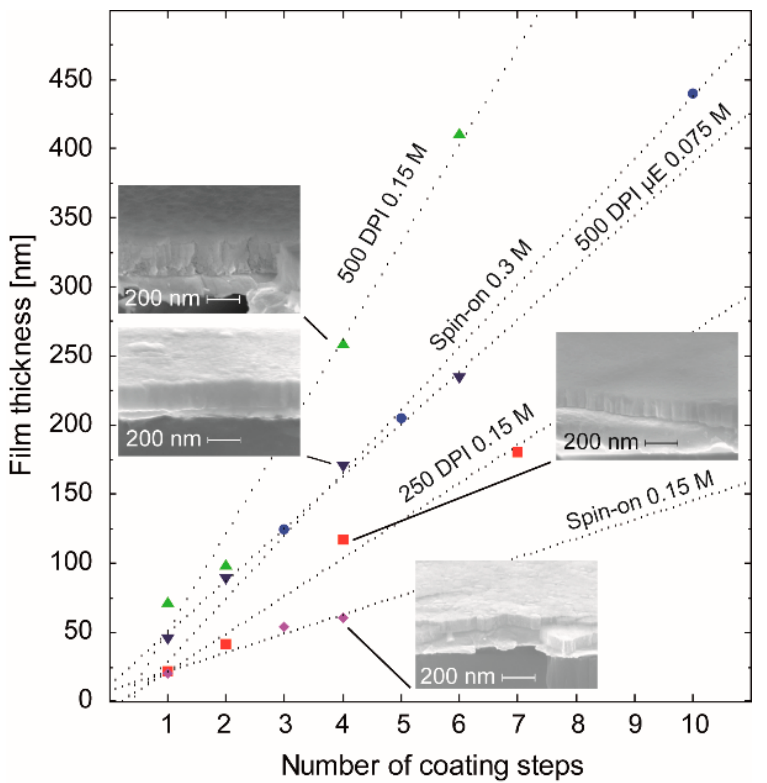
Figure 11. Correlation of the film thickness with the number of coating steps using different coating conditions for ink- 1 and ink- 2 ( µ E), namely spin coating at 3000 rpm (Spin-on 0.15 M) and ink jet printing with two different resolutions (250 DPI 0.15 M, 500 DPI 0.15 M, and 500 DPI µE 0.075 M). The corresponding behavior of films obtained from the spin coated original con-BZY stock solution was plotted as well. The cross section SEM images of the four insets show the microstructure of films produced by four coating steps using ink- 1 and ink- 2.